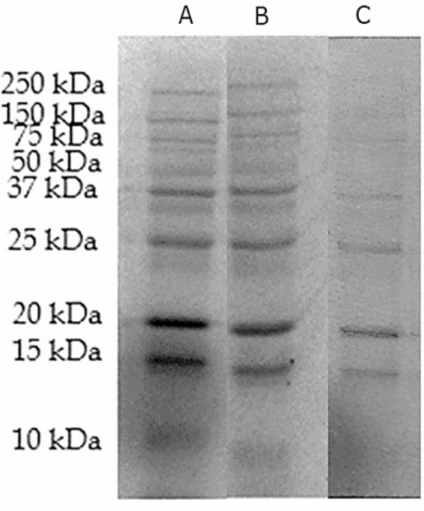
Figure 6. SDS-PAGE for proteins extracted from, ( A ) MCF-7 cancer cell line treated with DOX-Ar- CC-NPs. ( B ) MCF-7 cancer cell line treated with DOX. ( C ) Untreated MCF-7 control group. Proteomic analysis of MCF-7 cancer cell line treated with DOX and DOX-Ar-CC-NPs were evaluated through the LC-MS/MS method. The Venn diagram (Figure 7) shows the number of proteins expressed in both cultures (DOX and DOX-Ar-CC-NPs). A total of 334 proteins have been expressed in DOX-Ar-CC-NPs treated cells, while 54 proteins expressed in only the DOX treatment. Out of the 334 proteins expressed in DOX-Ar-CC- NPs treated cells, 36 protein IDs showed elevation in protein abundance (Table 2), while in DOX-treated cells, it was revealed that there were 7 proteins elevated in abundance out of 54 proteins (Table 3).